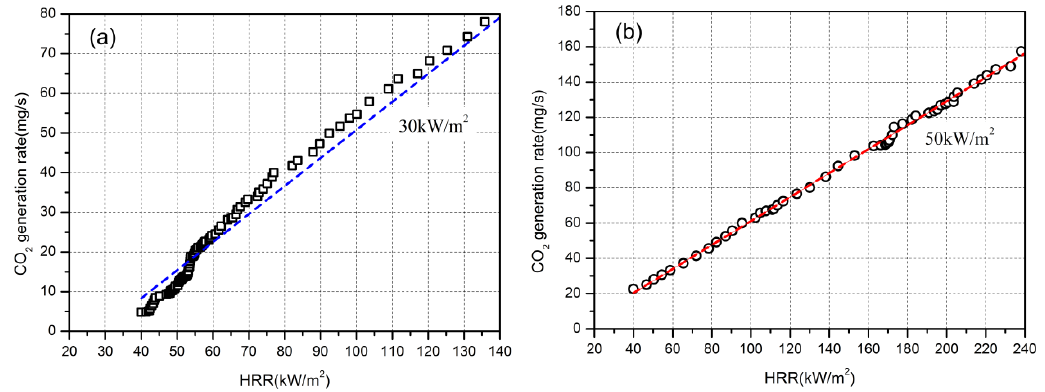
Figure 10. CO/CO 2 ratio in relation to heat flux. ( a ) aluminum-polyurethane; ( b ) pure polyurethane.